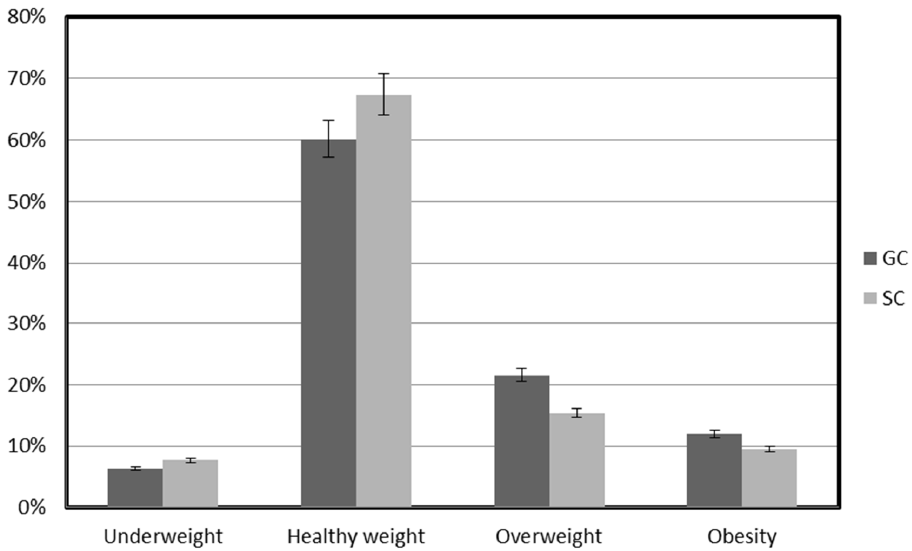
Figure 1. Categorization of body fat content in GC and SC children during the study period. GC— general education classes (standard PA, 4 h a week); SC—sport classes (elevated PA, 10 h). The highest mean percentage of underweight children was noted at the beginning of the study (grade 4, mean age 10.27 years) and concerned on average 10.75% of the children (GC 10.28%; SC 11.22%; p = 0.756) (Table 2). The lowest one occurred at the end of the study and concerned on average 3.39% of children (GC 4.04%; SC 2.75%; p = 0.039). The highest mean percentage of normal body fat content was found in the children of grade 6 (mean age 12.26 years) and concerned on average 66.27% of the children (GC 56.29%; SC 76.25%; p = 0.047). The lowest one was noted in grade 4 (mean age 10.27 years) and concerned on average 60.73% of the children (GC 61.61%; SC 59.86%; p = 0.953). The highest mean percentage of overweight children was noted at the end of the study (grade 6, mean age 12.26 years) and concerned on average 20.59% of the children (GC 26.65%; SC 14.53%; p = 0.017). The lowest one was noted at the beginning of the study (grade 4, mean age 10.90 years) and concerned on average 17.37% of the children (GC 20.78%; SC 13.96%; p = 0.020). The highest mean percentage of obese children occurred in grade 4 (mean age 10.90 years) and concerned on average 11.71% of the children (GC 11.52%; SC 11.91%; p = 0.400). The lowest one was noted at the end of the study (grade 6. mean age 12.26 years) and concerned on average 9.75% of the children (CG 13.02%, SC 6.47%; p = 0.026).